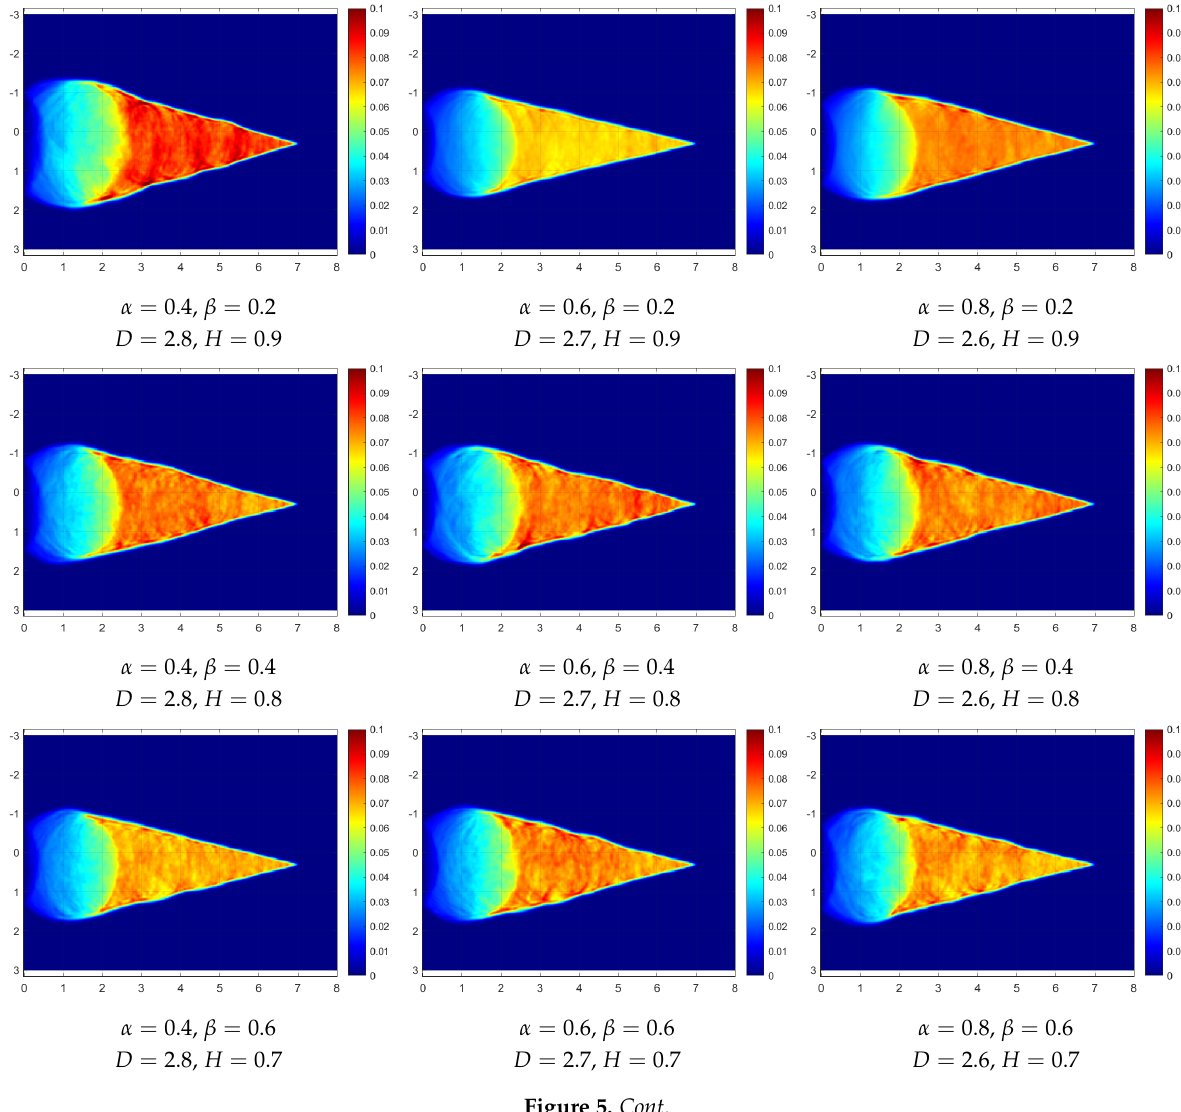
Figure 4. Simulation result at t = 3 in Cauchy random fields with columns (from left to right) at α = 0.2,1.0,1.8 and horizontal rows (from top to bottom) β =